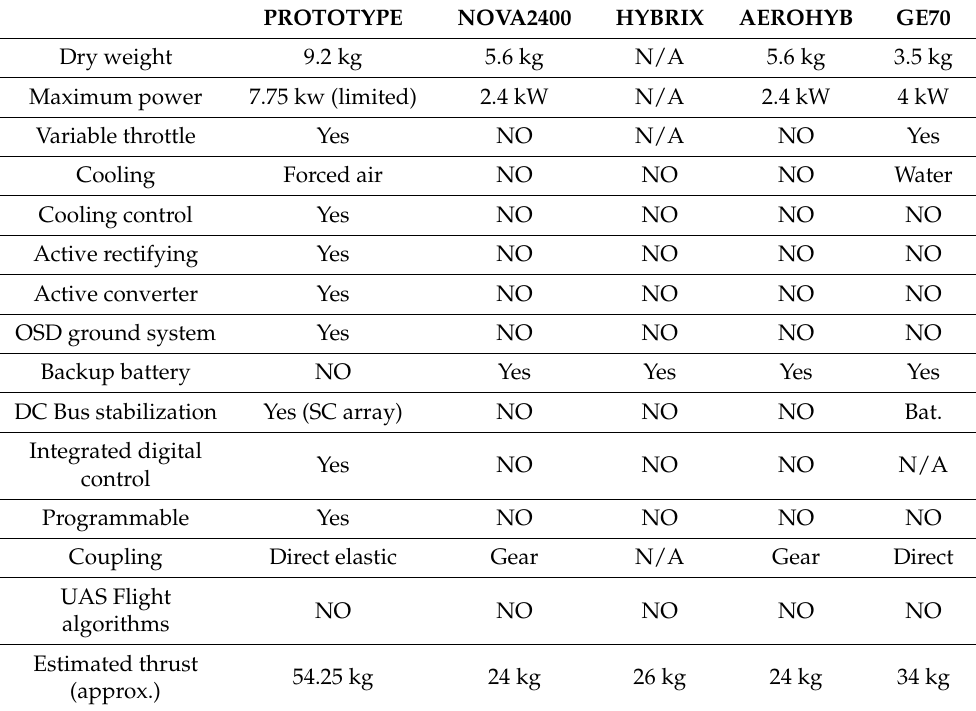
Table 8. Comparison of all systems with their functions. Indicates only overall base